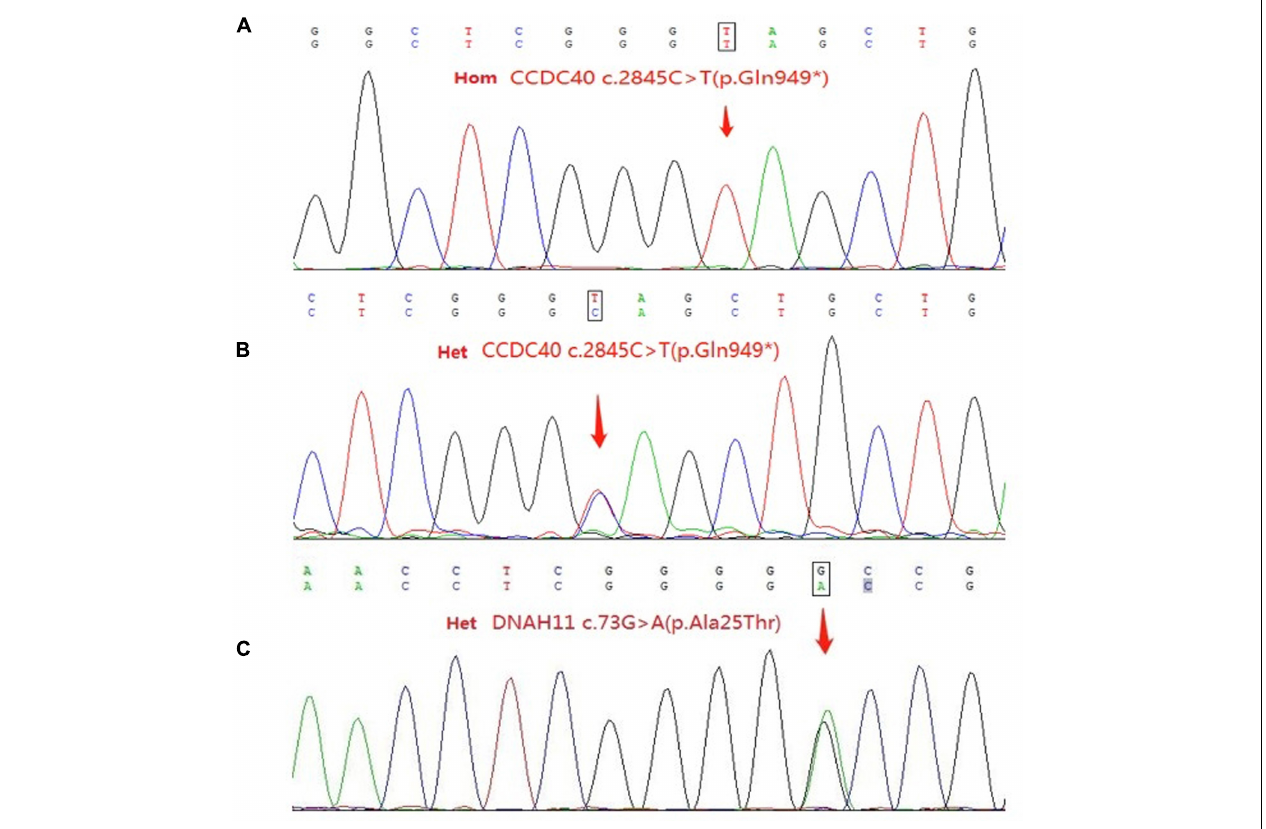
FIGURE 3 | (A) Sequence of the homozygous c.2845C > T (p.Gln949*) variant in the patient. (B) Sequence of the heterozygous c.2845C > T (p.Gln949*) variant among relatives of patient. (C) Sequence of the heterozygous c.73G > A (p.Ala25Thr) variant in the patient and her father. Het, heterozygous; Hom,